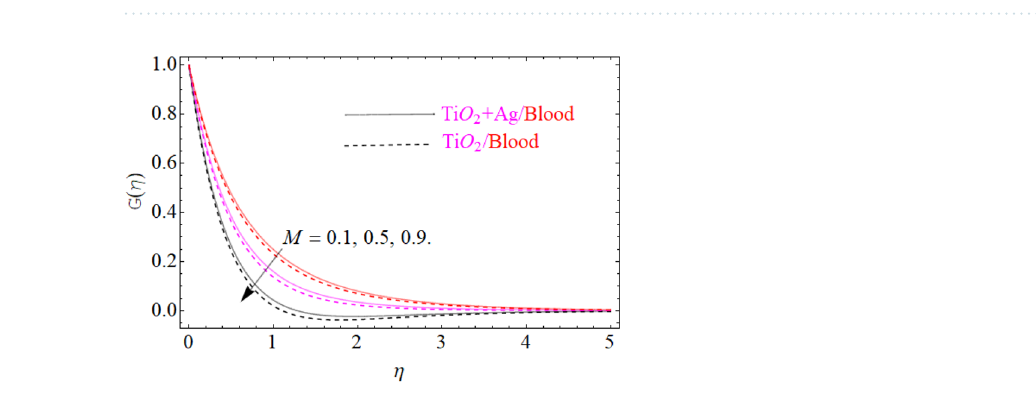
Figure 5. Under the influence of (cid:31) ∗ (mixed convection parameter), F ′ (η) .